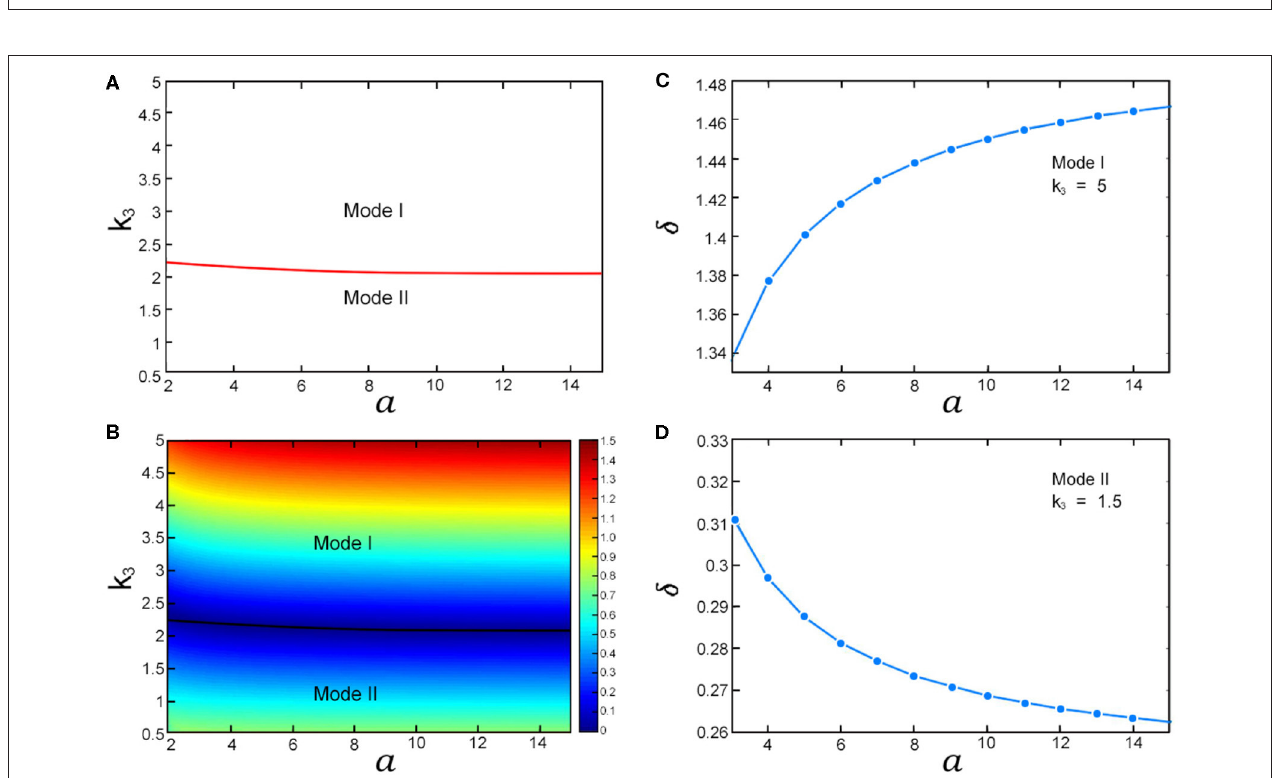
FIGURE 4 | The influences of k 3 and a on gene’s “off” and “on” states. (A) The areas of Mode I and Mode II in a - k 3 plane; (B) The heat map of gene’s state dominance factor δ in a - k 3 plane. The black line is the boundary between Mode I and Mode II; (C) The curve between δ and a in Mode I; (D) The curve between δ and a in Mode II. The values of other parameters are listed in Table S1